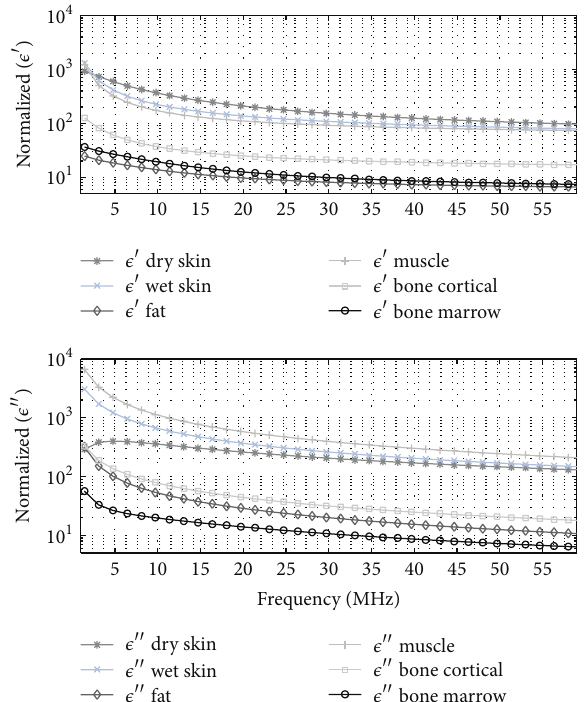
Figure 2: Normalized complex permittivity, that is, normalized 𝜖 󸀠